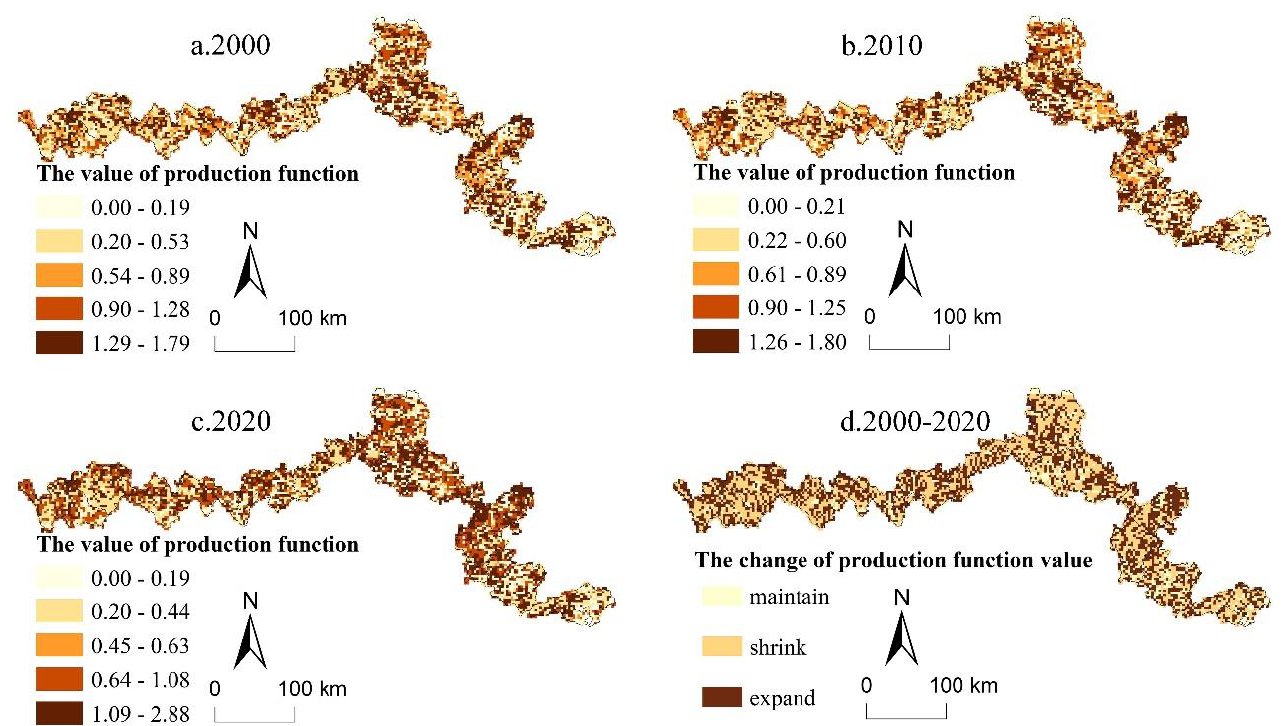
Figure 2. Production function value in the Sino–Vietnamese border region in ( a ) 2000, ( b ) 2010, ( c ) 2020 and ( d ) the change between 2000 and 2020.